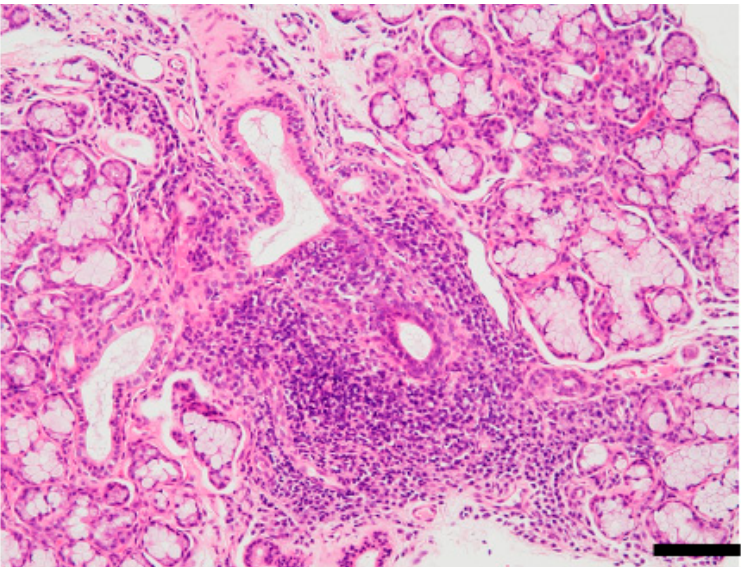
Figure 1. Focal lymphocytic sialadenitis of Sjögren’s syndrome (SS). Hematoxylin and eosin (HE)- stained section of minor salivary glands prepared from lip biopsy from a patient with SS. Notice the lymphocytic infiltration around the salivary ducts and the atrophy of acinar cells. Pathological diagnostic criteria of SS is ≥ 1 focus score or Greenspan grade ≥ 3 [32,33]. One focus refers to an aggregate of ≥ 50 mononuclear cells, including lymphocytes, histiocytes, and plasma cells around the ductal structure. Scale bar: 100 μ m. The image is unpublished.